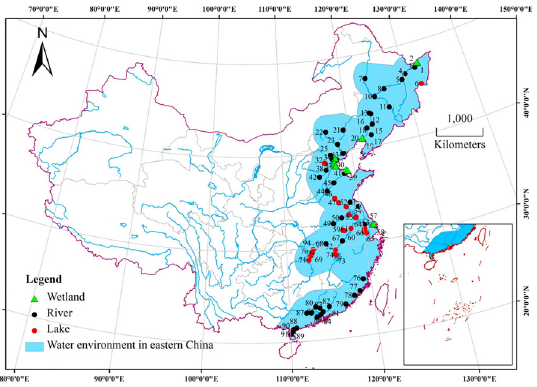
Fig 1. Location of the 89 sampling sites in Eastern China. Sites were distributed throughout Heilongjiang, Liaoning, Hebei, Shandong, Jiangsu, Anhui, Hubei and Guangdong provinces, as well as Beijing, Tianjin and Shanghai municipalities. River, wetland and lake systems, prominent ecosystems in the Eastern China, are